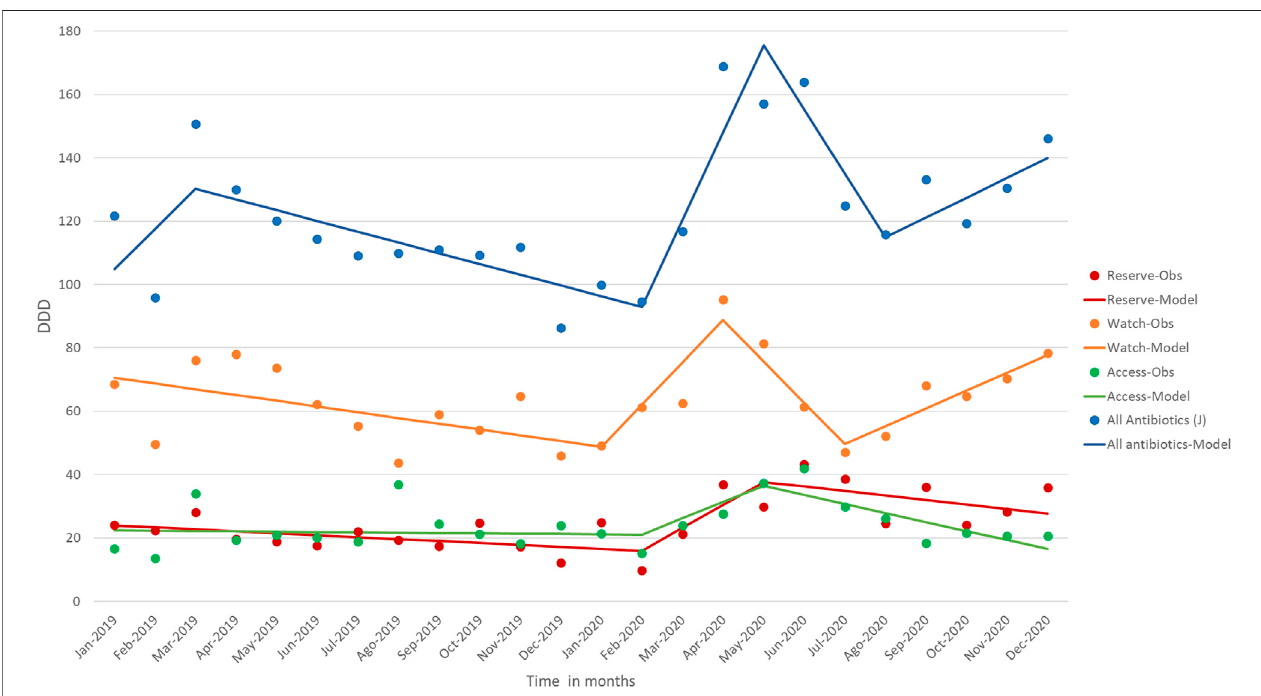
FIGURE 1 | Antibiotic consumption (DDD) for Overall (J (J01 and J02)) and Access, Watch and Reserve from January 2019 to December 2020 (Rio de Janeiro, Brazil).